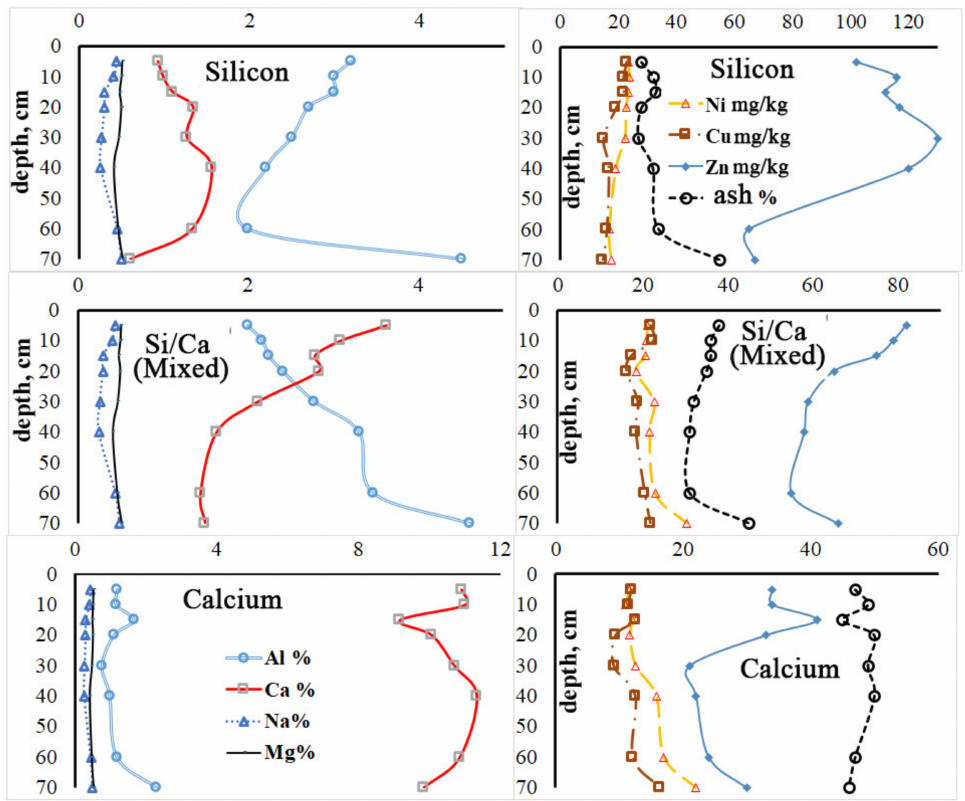
Figure 5. Vertical distribution of the averaged contents of Al (%), Ca (%), Na (%), Mg (%), Ni (mg/kg), Cu (mg/kg), Zn (mg/kg) and ash content (%) in sapropel sediments of organic–mineral type in the various classes (Silicon, Calcium, Si/Ca (mixed)) along cores (according to our